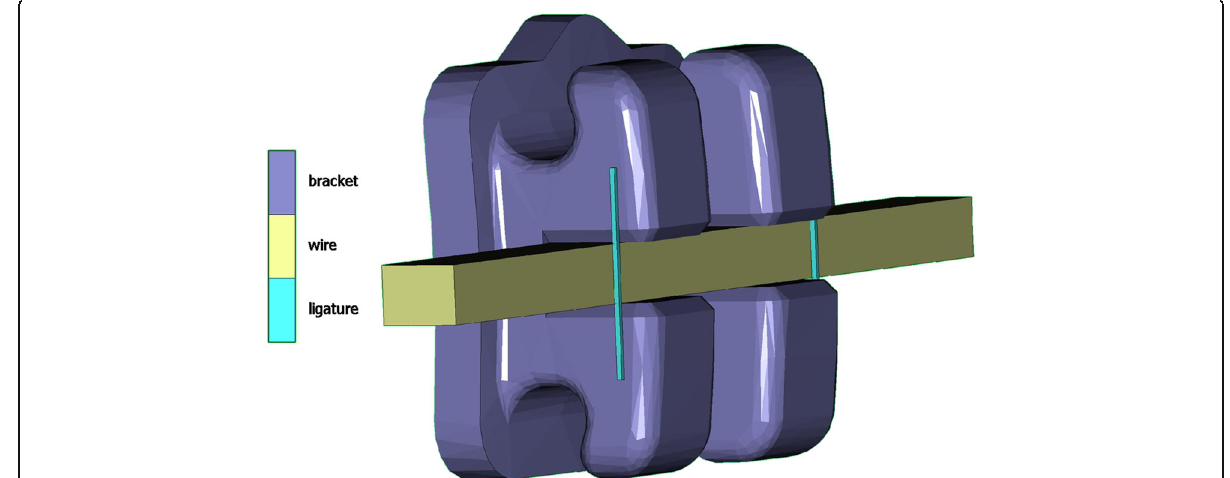
Fig. 2 Details of the bracket, wire, and ligatures